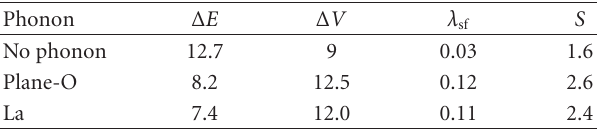
Table 1: Total energy ( Δ E , mRy per Cu), matrix element for spin fluctuations ( Δ V in mRy), λ sf , and local Stoner enhancement, S , calculated for lattices of LBCO with two phonon distortions and without distortions.